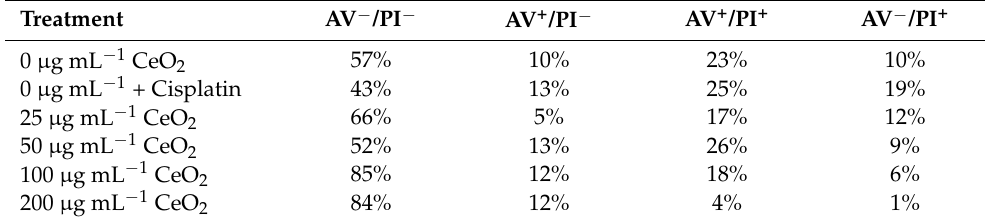
Table 2. Flow cytometry gated profiles of viable (AV − /PI − ), early apoptotic (AV + /PI − ), apoptotic and necrotic (AV + /PI + ), and already dead (AV − /PI + ) cells treated with varying concentrations of CeO 2 NP, or Cisplatin and irradiated with 0.1 Gy ionizing radiation.